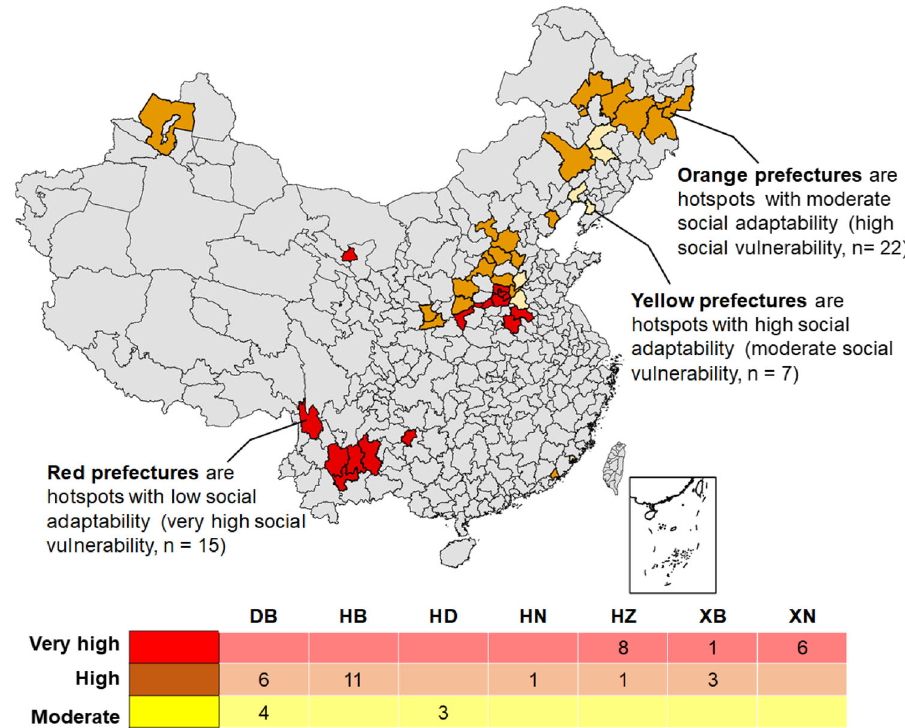
Fig. 3 Gradient of social vulnerability derived from the combination of water scarcity, climate sensitivity, and social adaptability. The “ very high ” vulnerability was derived by combining high water scarcity, high sensitivity, and low social adaptability; the “ high ” vulnerability was derived by combining high water scarcity, high vulnerability, and moderate social adaptability; the “ moderate ” vulnerability was derived by combining high water scarcity, high vulnerability, and high social adaptability. The vulnerable gradients were only conducted in the 44 hotspot prefectures. Hotspot prefectures (hotspots) are the ones with both high water scarcity and high climate sensitivity. Table shows the distribution of differe μ nt vulnerability gradients among the seven districts in